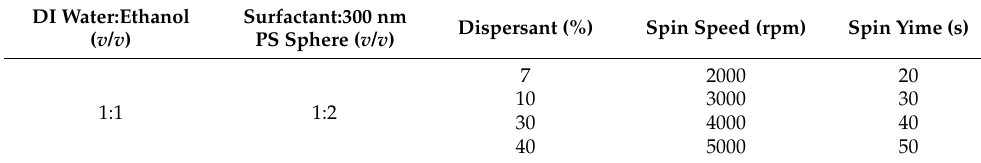
Table 1. The processing parameters used for self-assembly of 300 nm nanospheres.